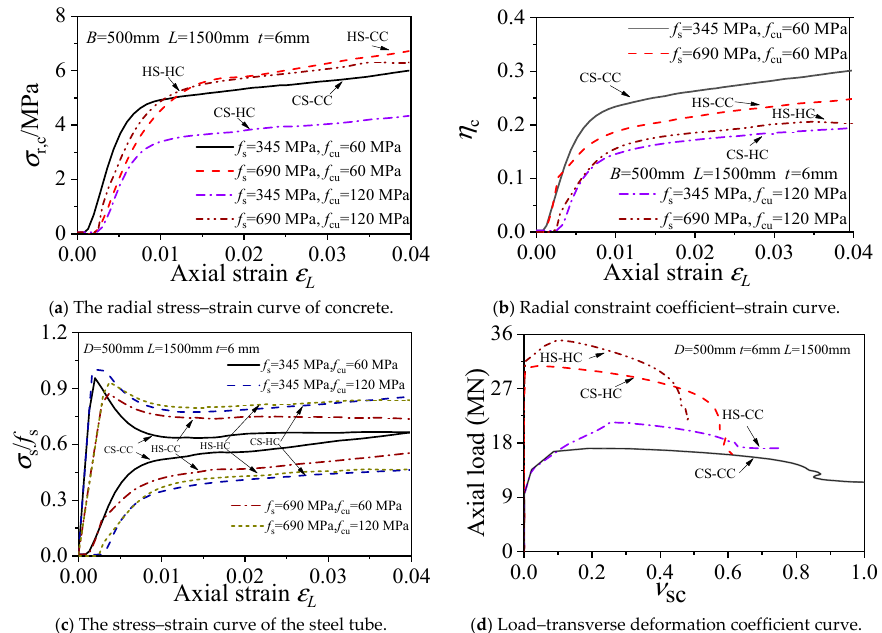
Figure 9. Comparison of axial compressive properties between high-strength specimen and ordi- nary specimen.